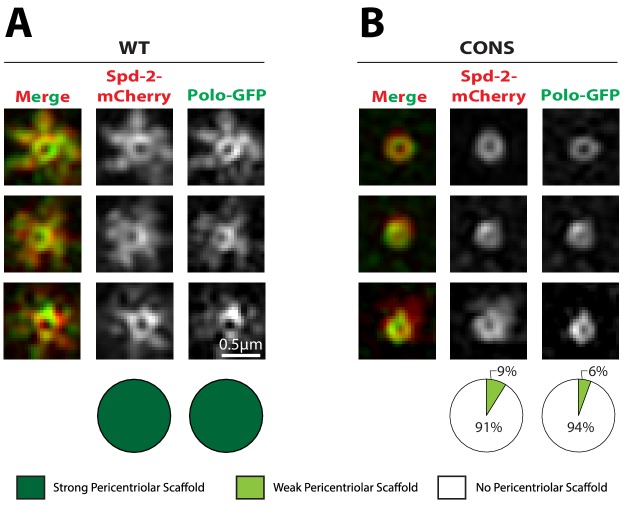
Polo is recruited to centrioles but cannot assemble into a PCM scaffold in Spd-2-CONS and Spd-2-ALL embryos.(A,B) Micrographs show 3D-SIM images of individual centrosomes from Spd-2 mutant embryos expressing Polo-GFP (green in merged images) and either WT Spd-2-mCherry (A) or Spd-2-CONS-mCherry (B) (red in merged images). Pie charts quantify the percentage of centrosomes that were scored qualitatively as having a strong (dark green), weak (light green) or no (white) pericentriolar scaffold (n = 15 individual centrosomes, two images (channels) per centrosome, for each genotype, respectively). All centrosomes were imaged in mid-late S-phase when the centrosomal levels of Spd-2 are maximal (see Figure 8). All scorings were performed blind by researchers not involved in the data acquisition. The defect in scaffold assembly is stronger in the Spd-2 mutant embryos expressing Polo-GFP and Spd-2-CONS-mCherry when compared to Spd-2 mutant embryos expressing just Spd-2-CONS-GFP (Figure 4). This appears to be due to a genetic interaction between Polo-GFP and Spd-2-CONS-mCherry, as mutant embryos expressing just Spd-2-CONS-mCherry had a similar phenotype to embryos expressing just Spd-2-CONS-GFP (data not shown) (see main text).10.7554/eLife.50130.026Figure 6—source data 1.Figure 6 source data, results from blind scoring.